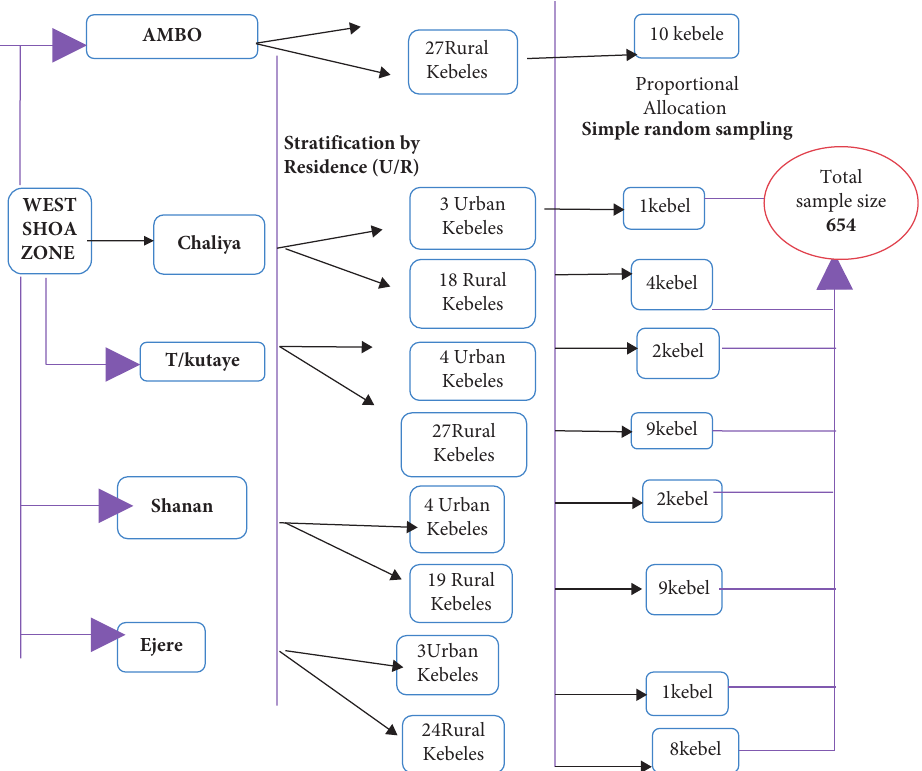
Figure 2: Schematic representation of women of reproductive age, West Shoa Zone, Ethiopia, 2018.